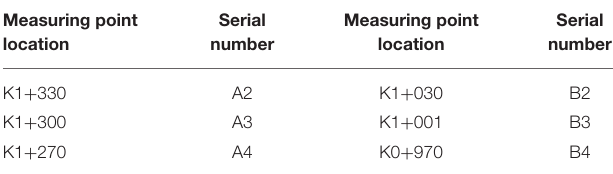
TABLE 3 | The location of the surviving